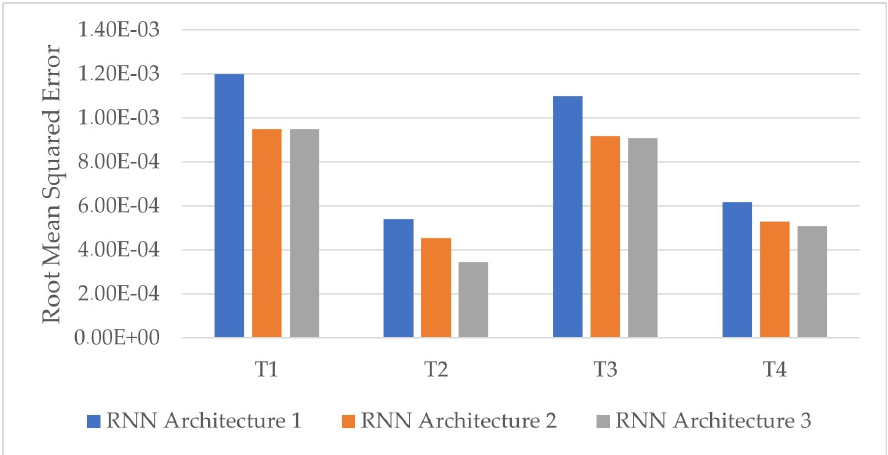
Figure 10. RMSE performance of the different RNN architectures for the four experimental